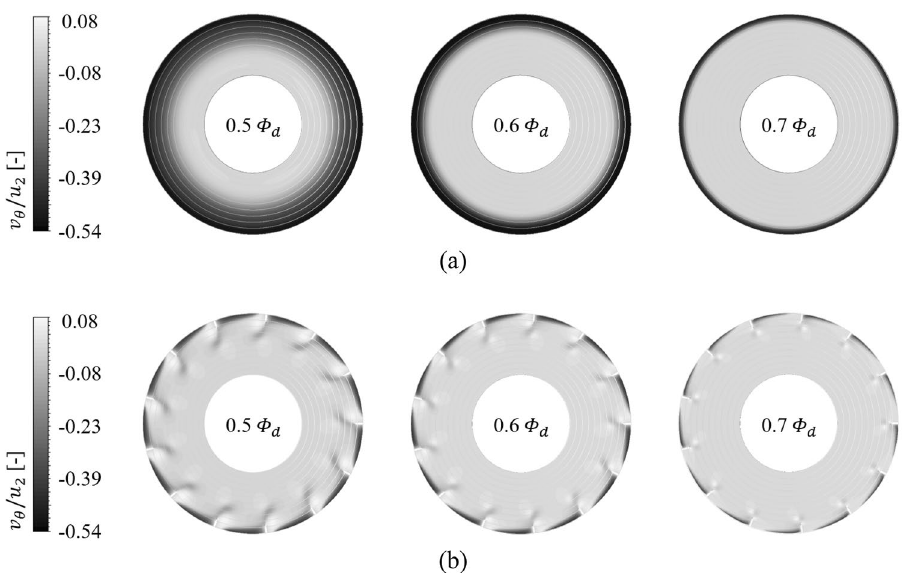
Figure 9. Circumferential velocity ( v θ ) contour on sectional plane for each ( a ) case of none and ( b ) ASF attached (0.5–0.7 Φ d